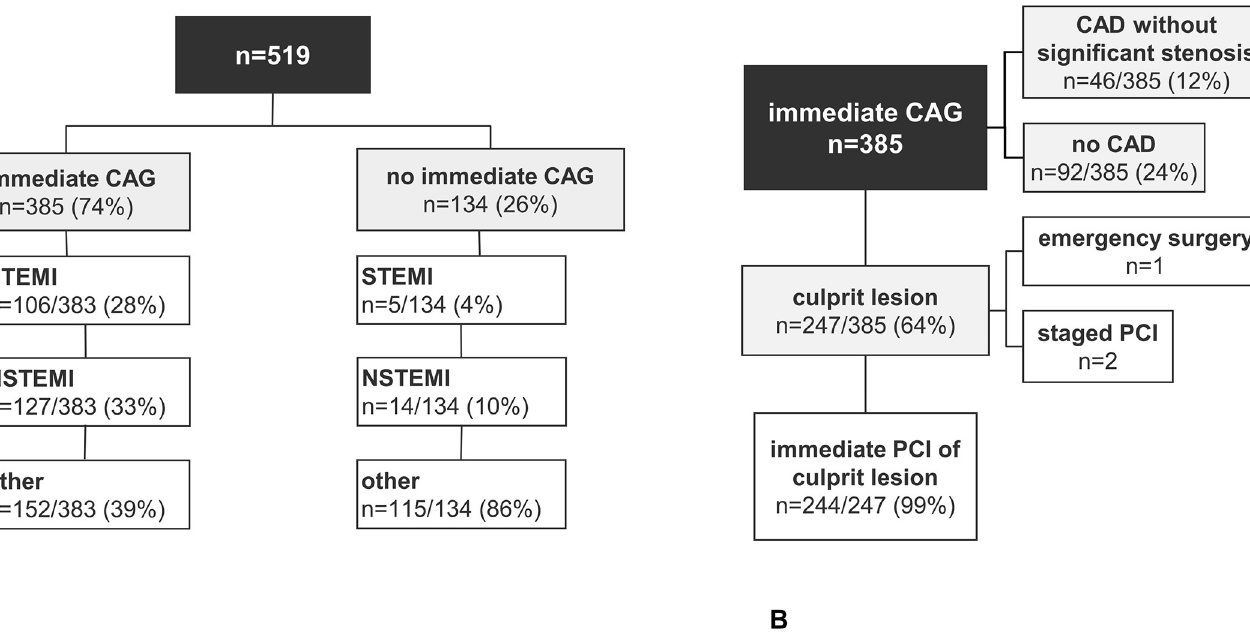
Data are presented as % of the total cohort.